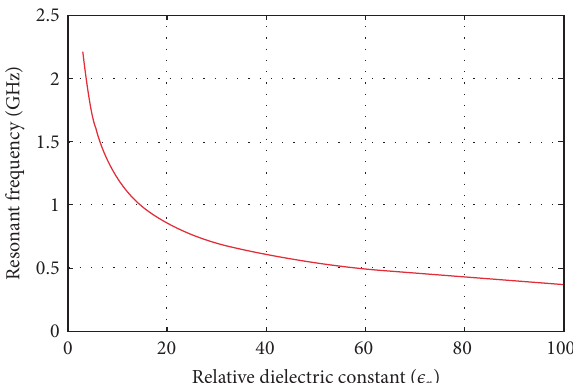
Figure 4: Resonant frequency of a cylindrical DRA with radius 𝑎 = 2.5 cm and height ℎ = 5cm as a function of the relative dielectric constant.